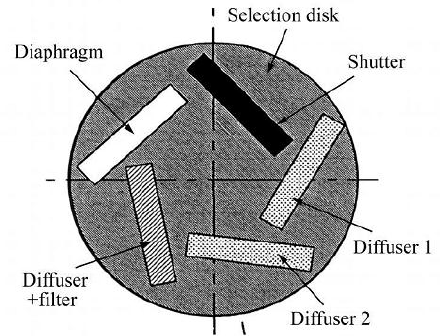
Figure 10. Solar calibration device of MERIS (LABANDIBAR JY, et al. 2004a)